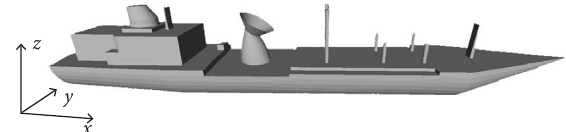
Figure 3: A surveillance